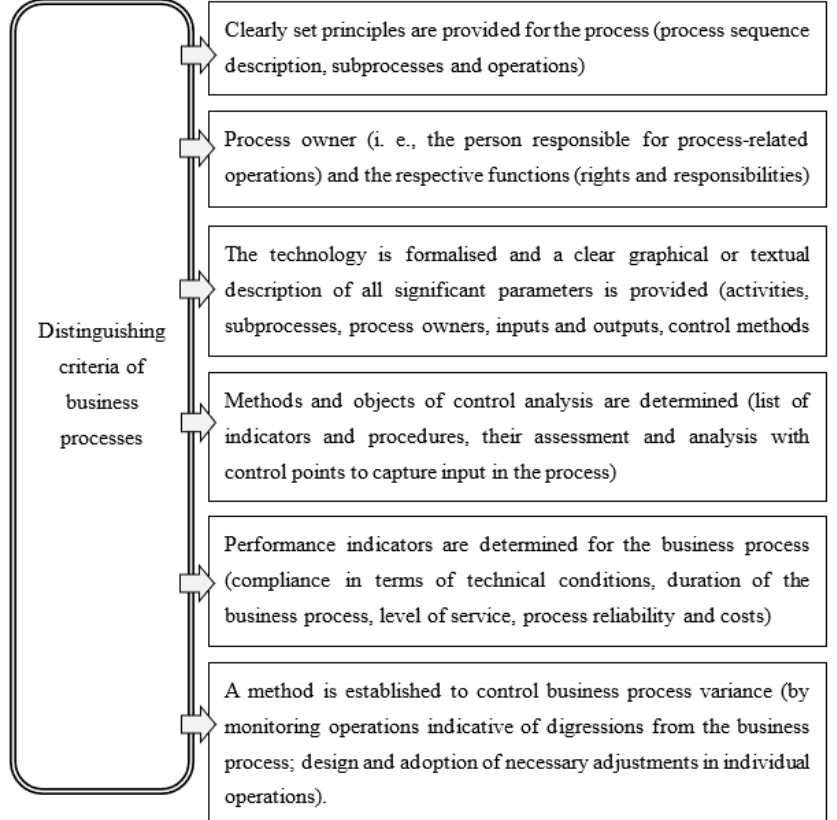
Figure 5. The composition and scope of criteria serving to distinguish between business processes for managing them, and the respective operations.